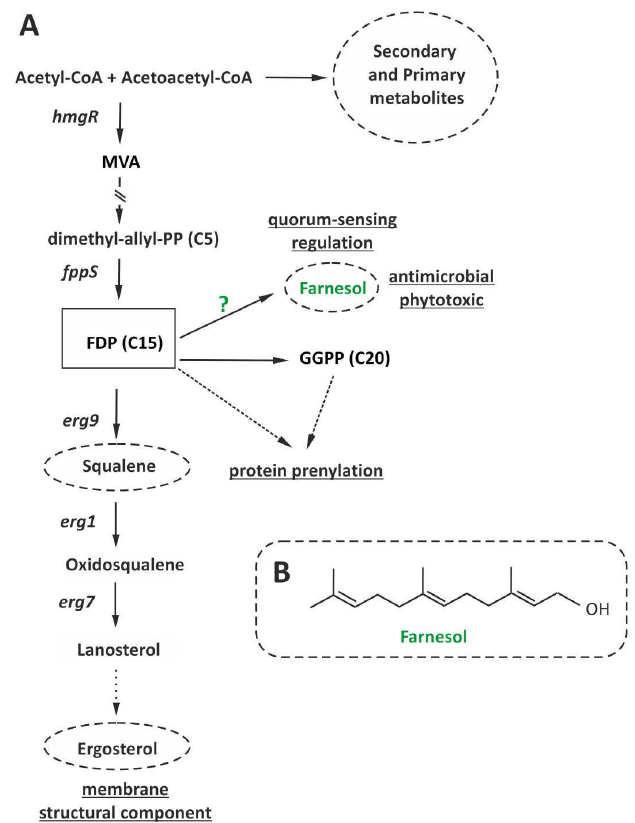
Figure 1. ( A ) Schematic representation of the ergosterol biosynthetic pathway, pointing out the genes analyzed in this study. FDP, farnesyl diphosphate; GGPP, geranyl geranyl pyrophosphate; MVA, mevalonic acid; hmgR , fppS , erg9 , erg1 , and erg7 , correspond to genes encoding for hydroxymethylglutaryl-CoA reductase, farnesyl diphosphate synthase, squalene synthase, squalene epoxidase, and oxidosqualene cyclase, respectively. A green question mark (?) was included to indicate the gene involved in FDP dephosphorylation whose identification is the main objective of the current study. ( B ) Chemical structure of farnesol.